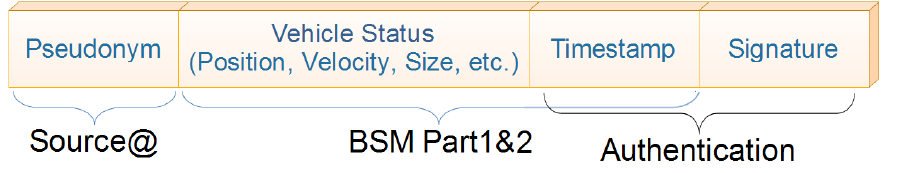
Figure 2. The basic safety message fields and